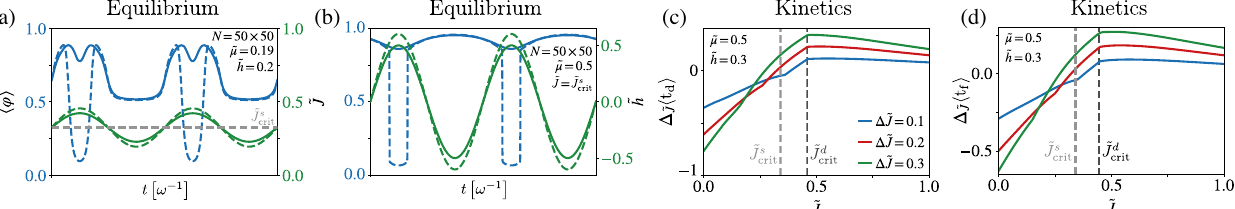
FIG. 10. Equilibrium and kinetic response to changes in cell stiffness, external force, or the binding affinity. Equilibrium response of the average fraction of closed bonds h φ ð t Þi to a slow (quasistatic), periodic modulation of (a) the coupling hence membrane stiffness) and (b) the external force ˜ J s critical coupling . (c,d) Change in mean dissolution (c) and formation (d) time per bond, Δ ˜ crit ˜ J response to a change Δ of the coupling, as a function of critical